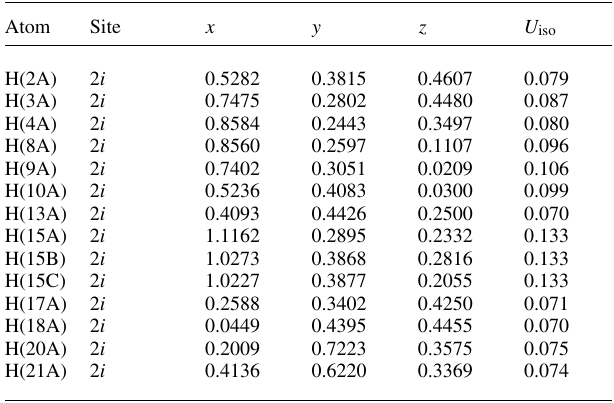
Table 2. Atomic coordinates and displacement parameters (in Å 2 )